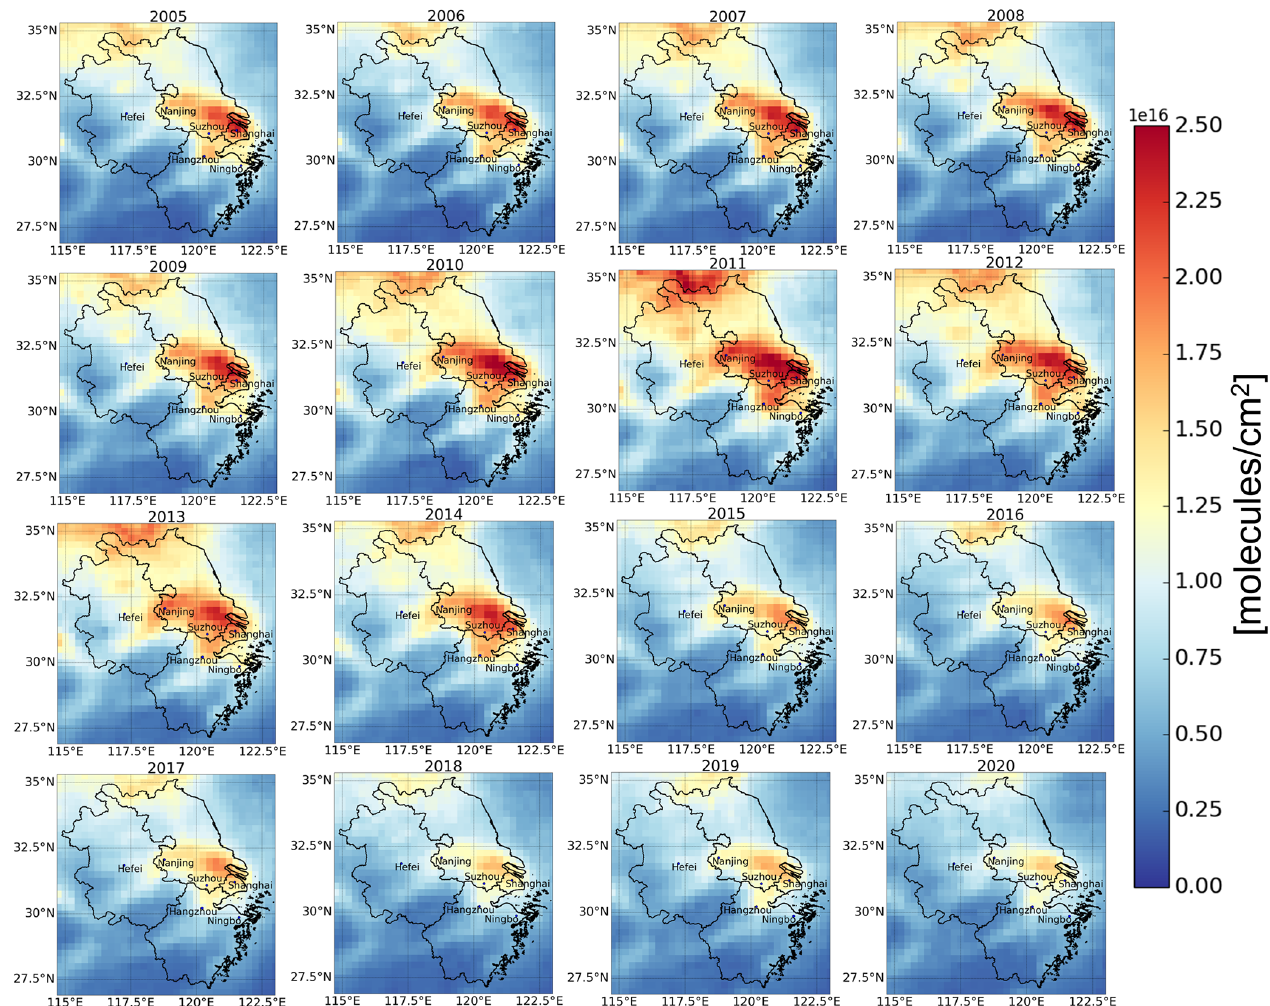
Figure 1. Temporal–spatial variabilities of NO 2 VCD trop provided by the OMI satellite over the YRD from 2005–2020. The three provinces (Anhui, Jiangsu, and Zhejiang) and six key megacities (Hefei, Nanjing, Suzhou, Shanghai, Hangzhou, and Ningbo) are